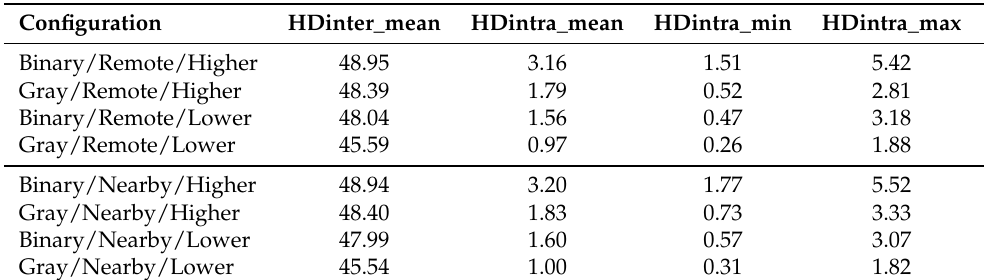
Table 4. HDinter mean and HDintra mean, min, and max values for different configurations of the PUFs included in the test systems implemented on the Pynq Z2